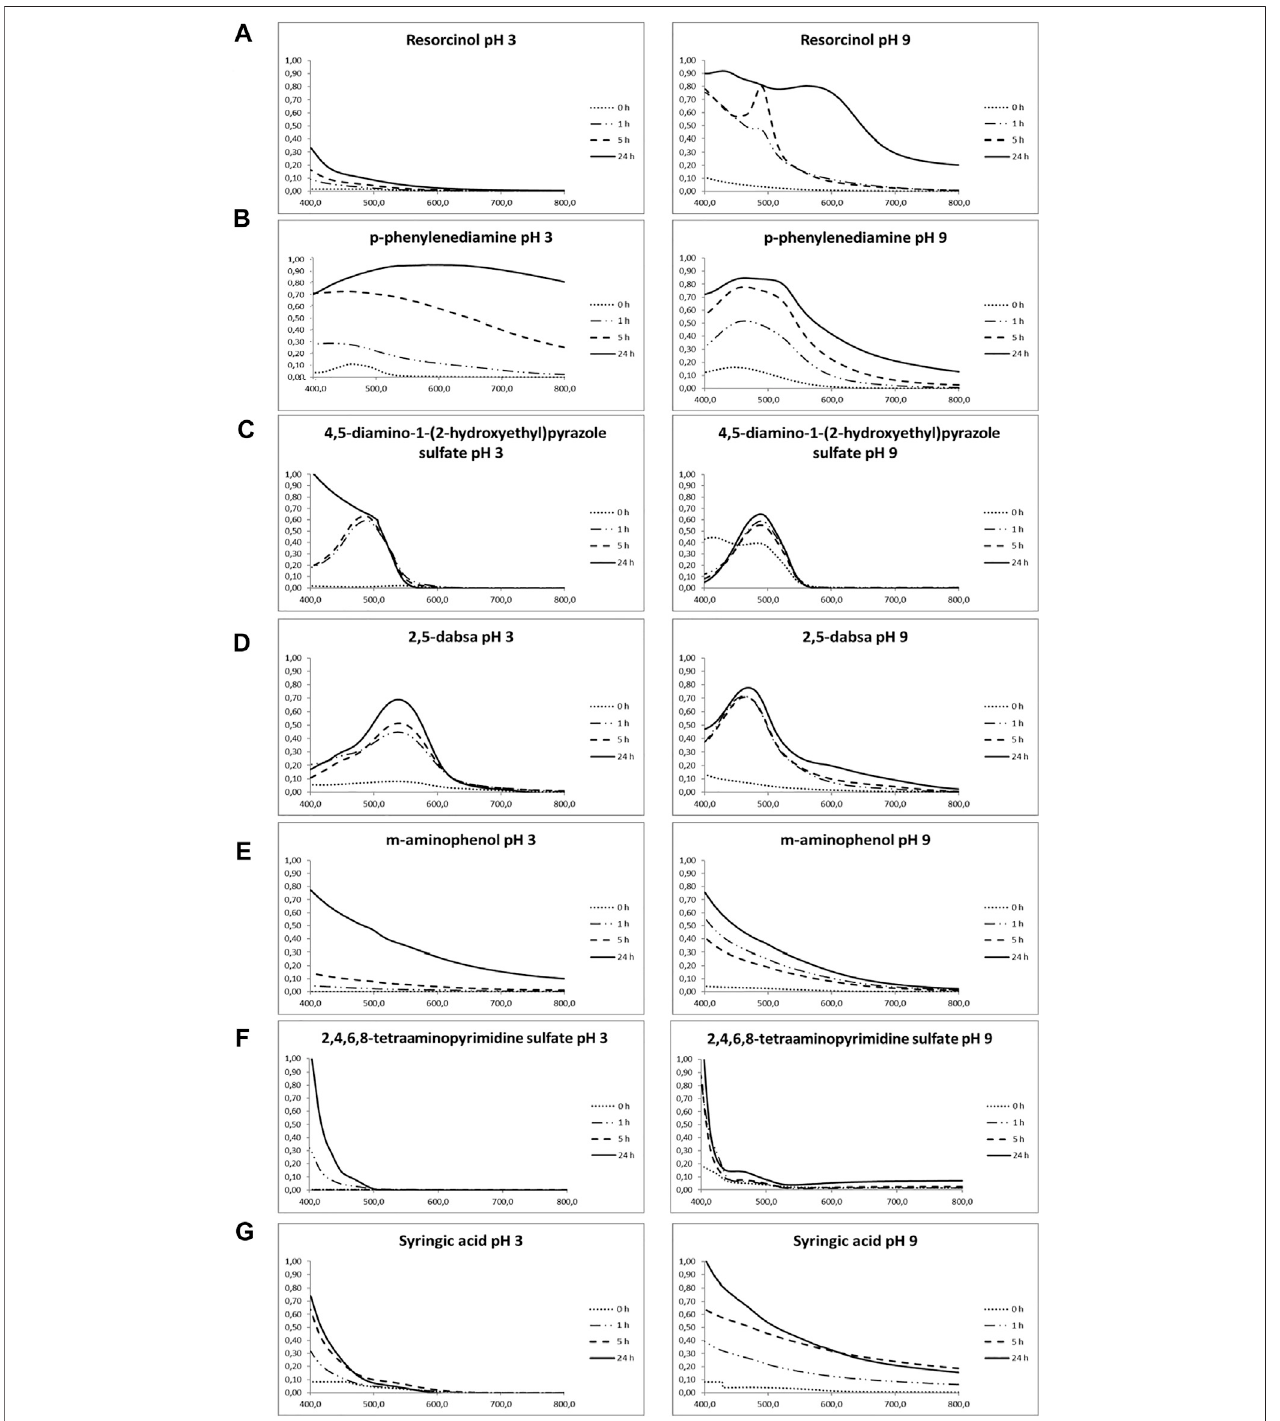
FIGURE 1 | Time-dependent visible light absorption spectra of the reacted solutions obtained at different times during the oxidation experiments. Diluted samples incubatedwithlaccasewereindicatedinbracket. (A) Resorcinol(5 hpH9,1:2diluted;24 hpH9,1:8diluted). (B) p -phenylenediamine(1 hpH3,1:10diluted;5 hpH3, 1:10diluted;24 hpH3,1:12diluted)(1 hpH9,1:4diluted;5 hpH9,1:5diluted;24 hpH9,1:7diluted). (C) 4,5-diamino-1-(2-hydroxyethyl)pyrazolesulfate(1 hpH3,1: 2 diluted; 5 h pH 3, 1:4 diluted; 24 h pH 3, 1:15 diluted) (1 h pH 9, 1:20 diluted; 5 h pH 9, 1:80 diluted; 24 h pH 9, 1:100 diluted). (D) 2,5-diaminobenzenesulfonic acid(0 hpH3,1:10diluted; 1 hpH3,1:20diluted; 5 hpH3,1:40diluted;24 hpH3,1:40diluted)(1 hpH9,1:4diluted; 5 hpH9,1:10diluted; 24 hpH9,1:20diluted). (E) m -aminophenol (1 h pH 9, 1:2 diluted; 5 h pH 3, 1:4 diluted; 24 h pH 3, 1:10 diluted). (F) 2,4,5,6-tetraaminopyrimidine sulfate (1 h pH 9, 1:4 diluted; 5 h pH 3, 1:4 diluted;24 hpH3,1:4diluted). (G) syringicacid(1 hpH3,1:4diluted;5 hpH3,1:4diluted;24 hpH3,1:4diluted)(1 hpH9,1:4diluted;5 hpH9,1:4diluted;24 hpH9, 1:5 diluted). Standard deviation of absorbance at λ max was less than 8%. Related controls are reported in Supplementary Figure S1 .